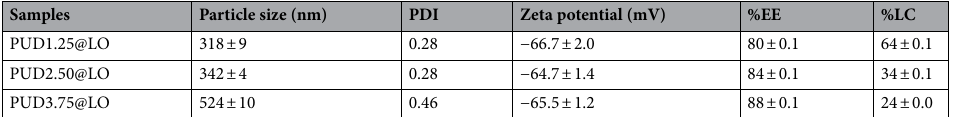
Samples Particle size (nm) PDI Zeta potential (mV)